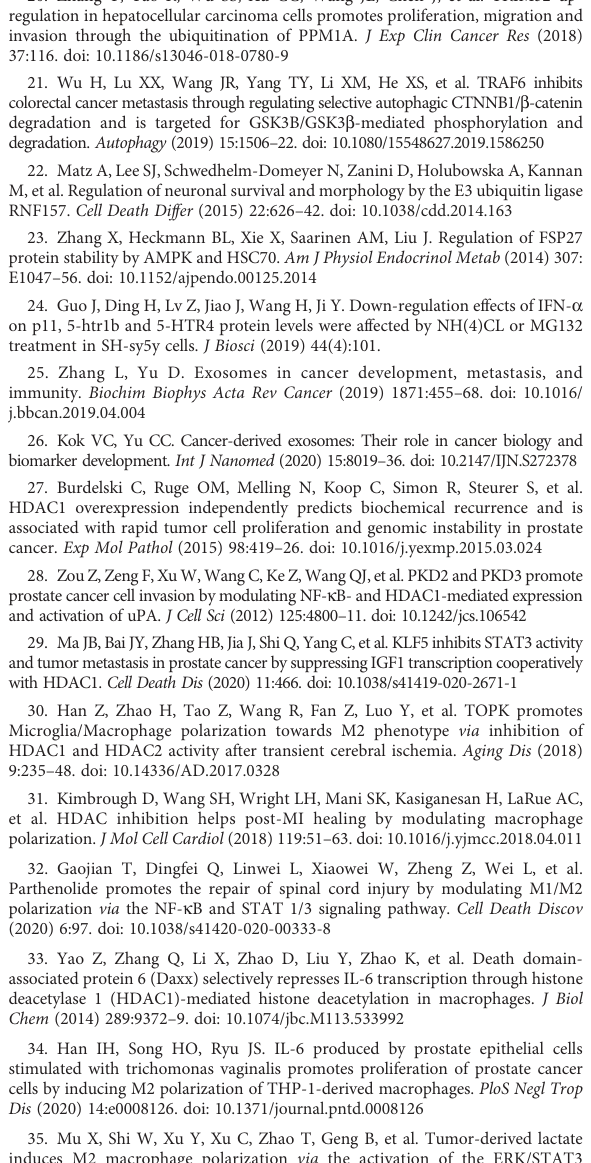
SUPPLEMENTARY FIGURE 2 Protein distribution was predicted on Hum-mPLoc